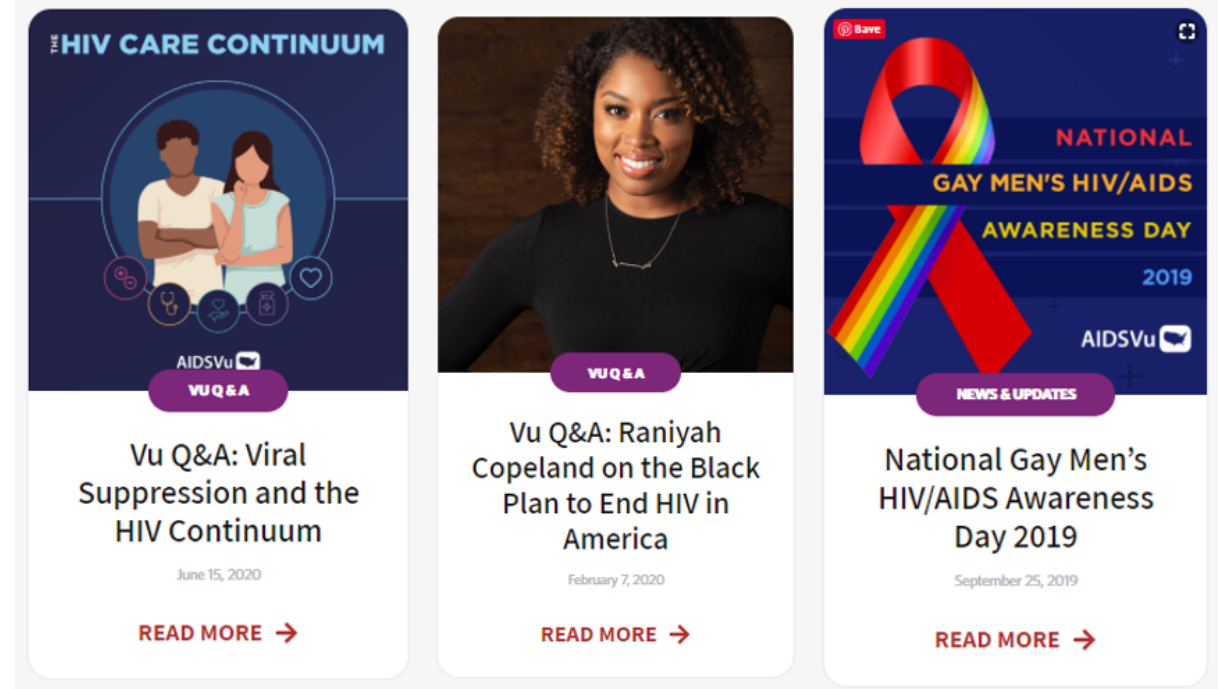
Figure 4. Examples of AIDSVu question-and-answer (Q&A)